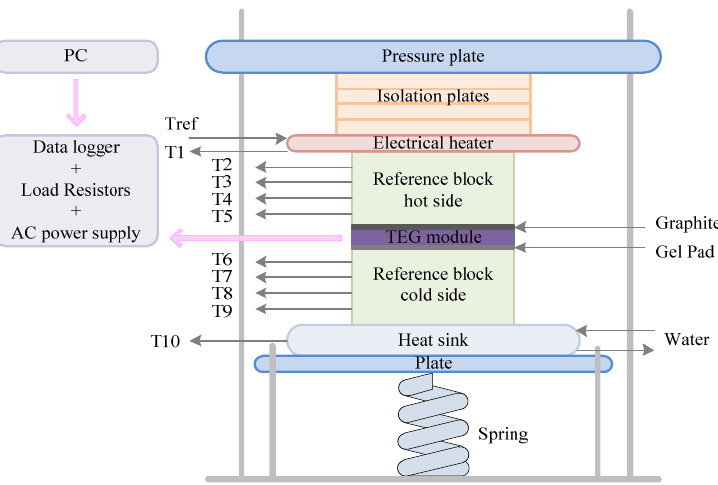
Figure 2. TEGeta block diagram.